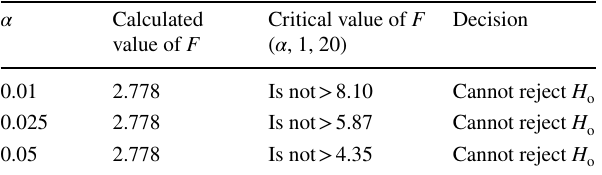
Table 6 Values of calculated F and critical F at different significant